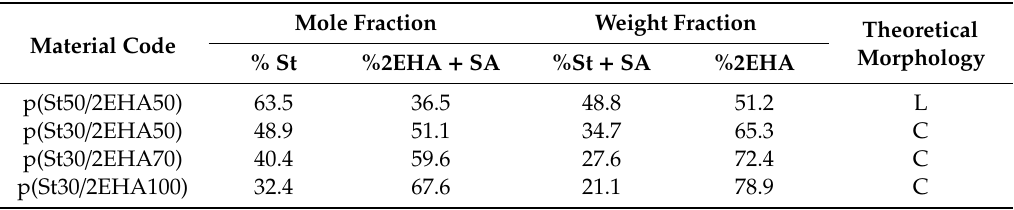
Table 3. Block copolymer composition determined by 1 H NMR spectroscopy and theoretical morphology